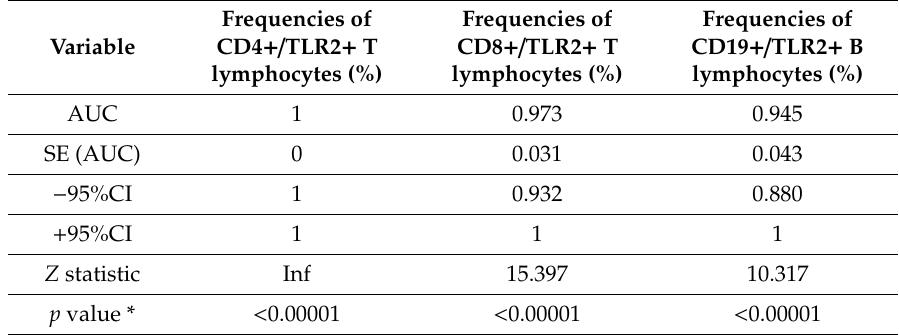
Table 5. ROC curve analysis to determine the diagnostic accuracy of TLR2 expression on T and B lymphocytes to discriminate between PGN and NPGN